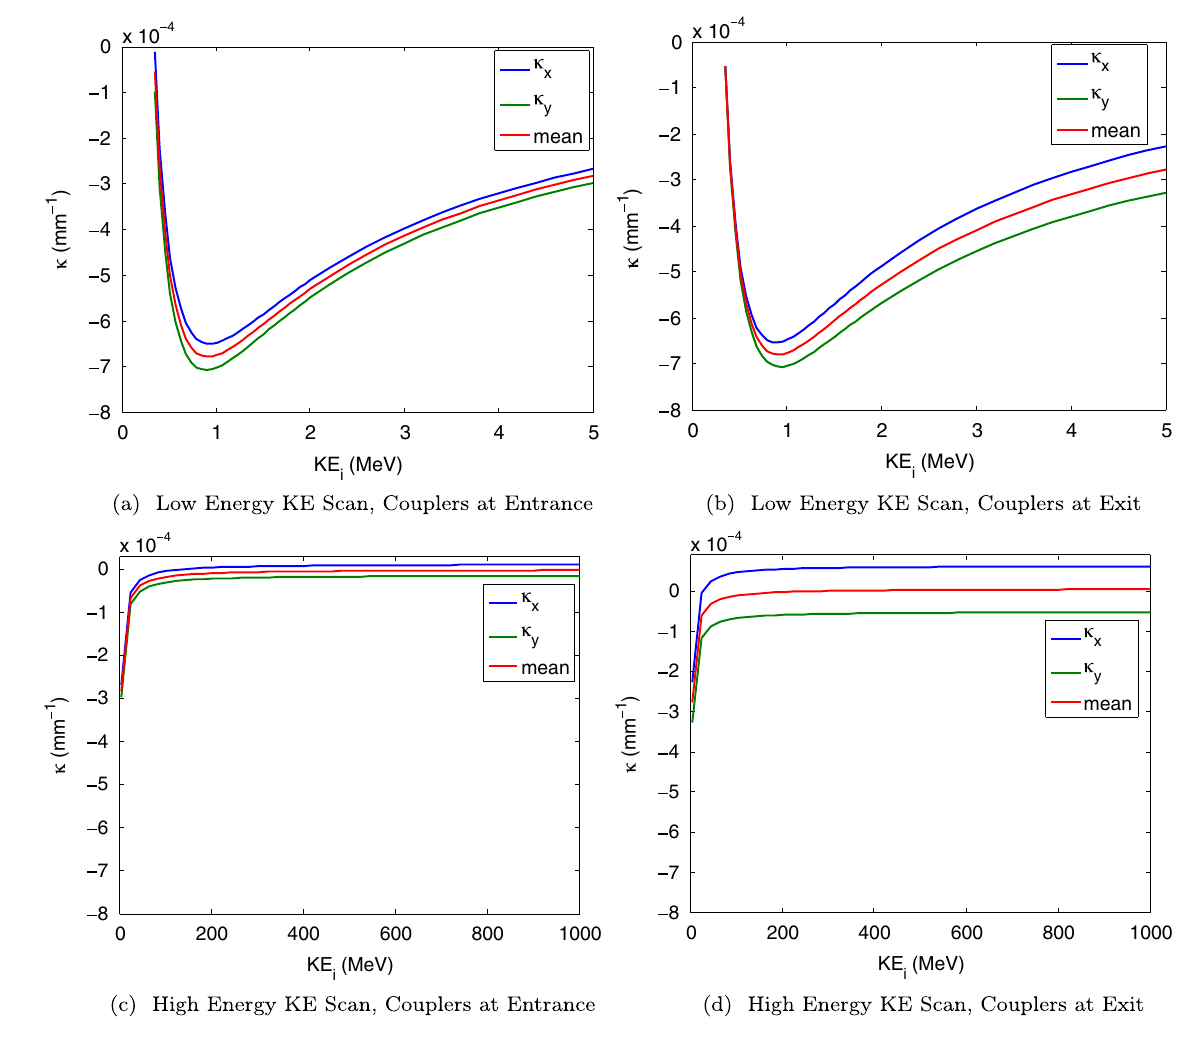
FIG. 10. Scans of the initial beam kinetic energy for both orientations of the cavity model.